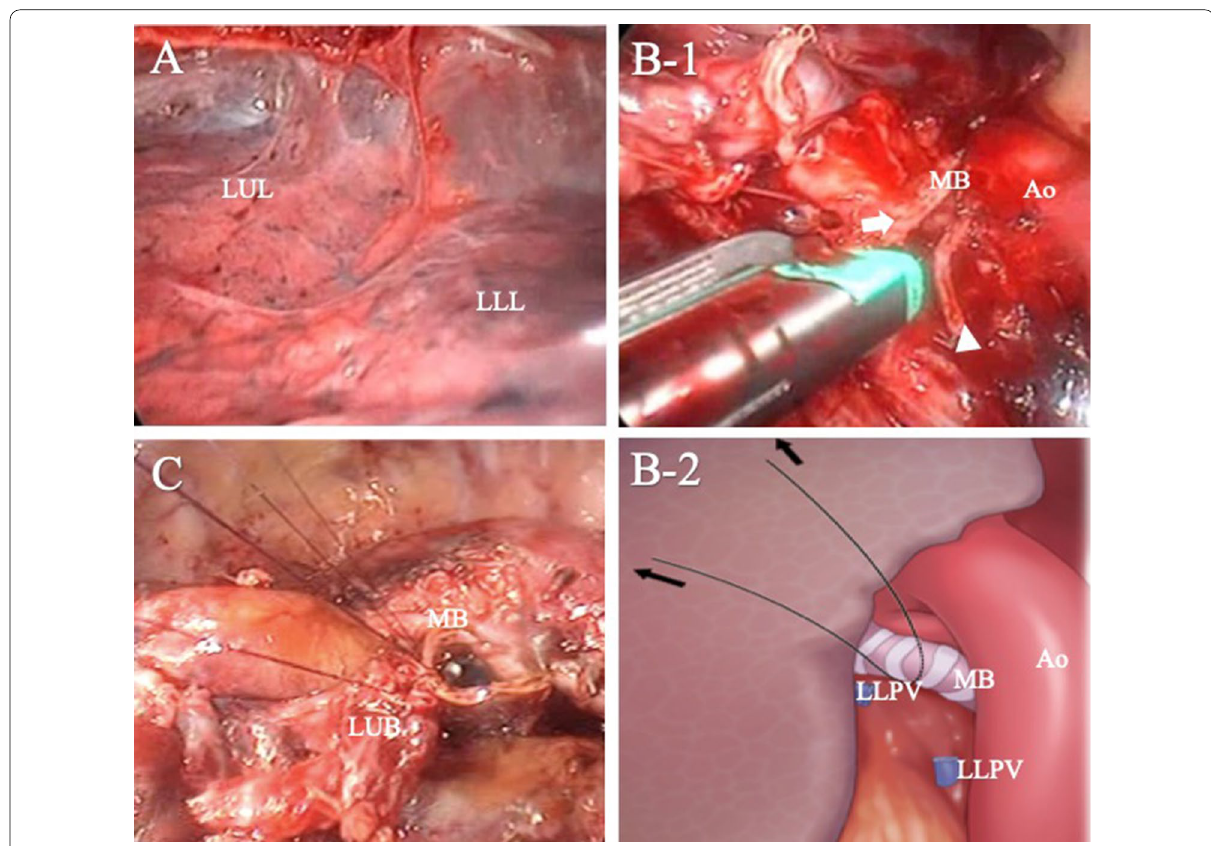
Fig. 2 The intraoperative views. a A fused fissure was present between the upper lobe and the left lower lobe. b-1 The main bronchus was mistaken for the left lower lobe bronchus and erroneously transected. Proximal stump (arrowhead), distal stump (arrow). b-2 The schema of b-1 . c Sleeve bronchoplasty was performed with the anastomosis of the left main bronchus and the left upper lobe